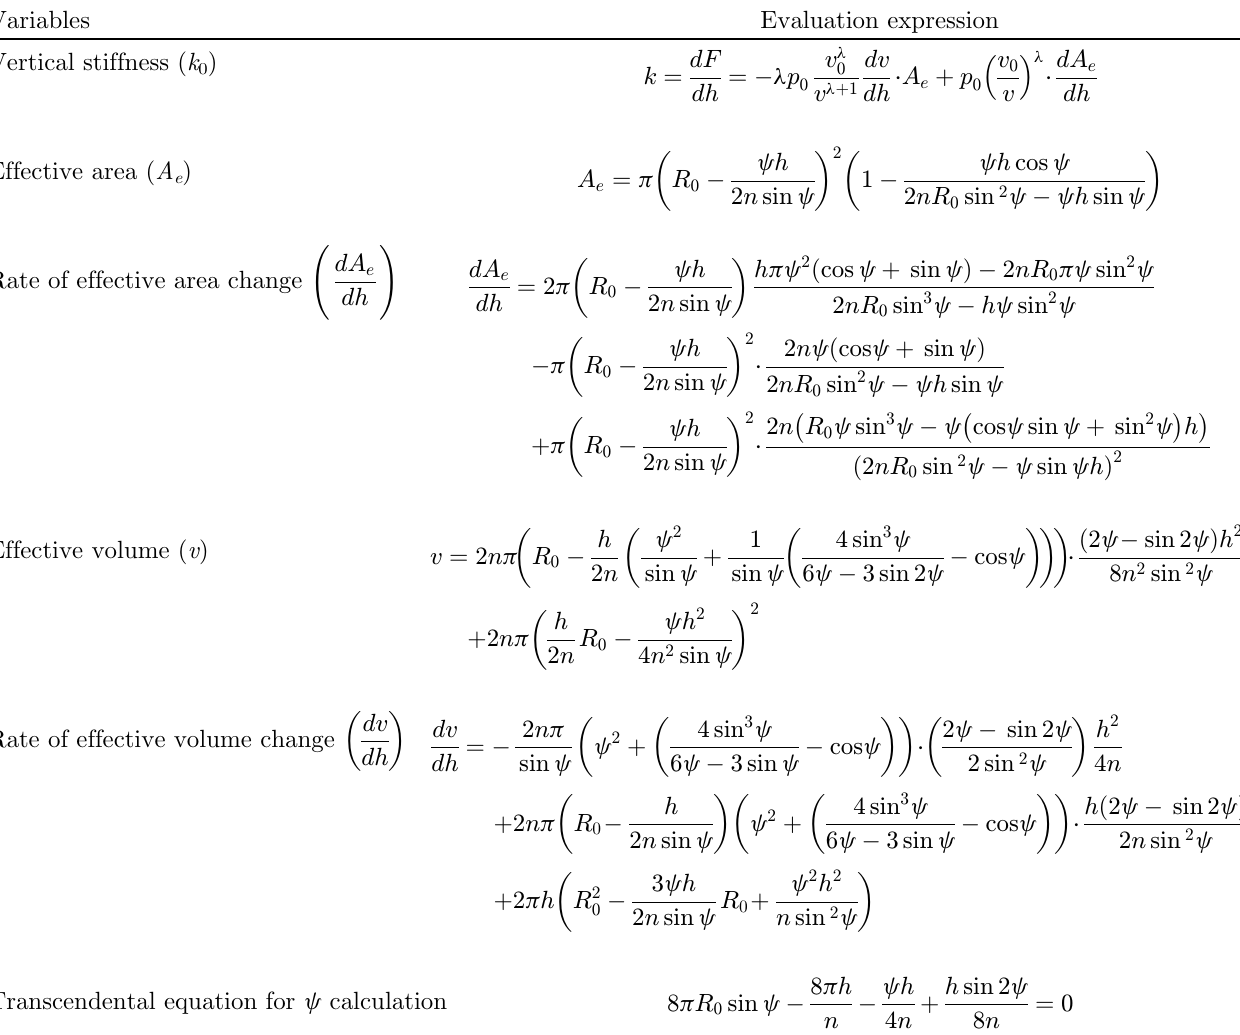
Table 4. Calculation formula of variables.